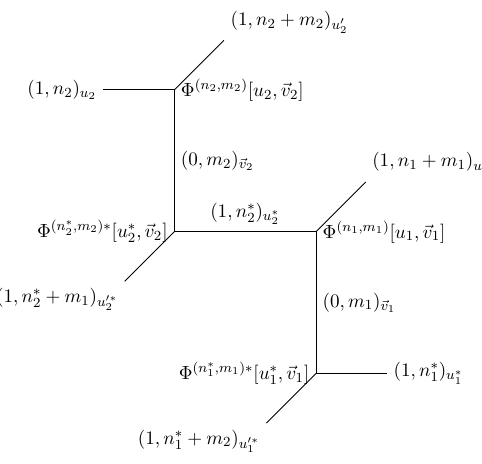
Figure 9 . Con(cid:12)guration relevant to the U( m 2 ) (cid:2) U( m 1 ) gauge